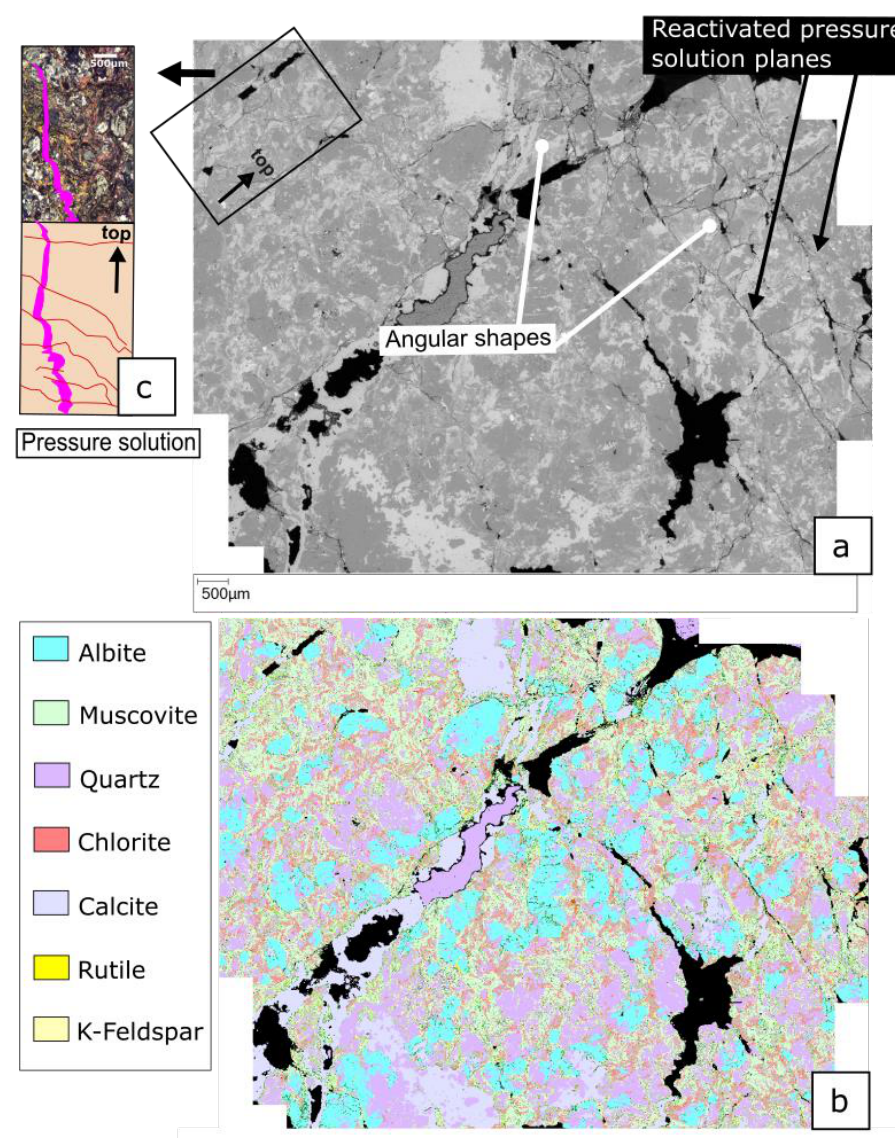
Figure 5. ( a ) Backscattered electron-scanning microscopy (BSE SEM) imaging, of a thin section perpendicular to the fault dip. The major mineralogical composition is colour coded in figure ( b ) (image of the EDX mapping). Picture in ( c ) shows a comparison of the BSE-SEM image of the same portion under cross-polarized light, showing pressure solution affecting a vertical calcite vein.